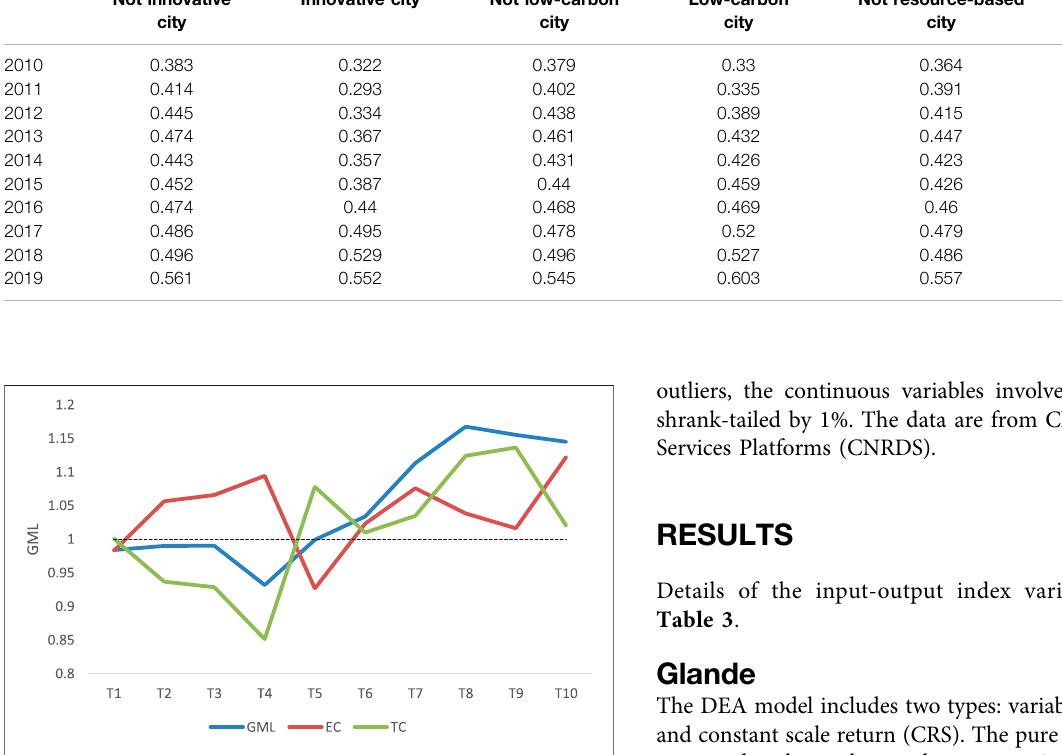
TABLE 5 | Glande of different types of cities. Not innovative city